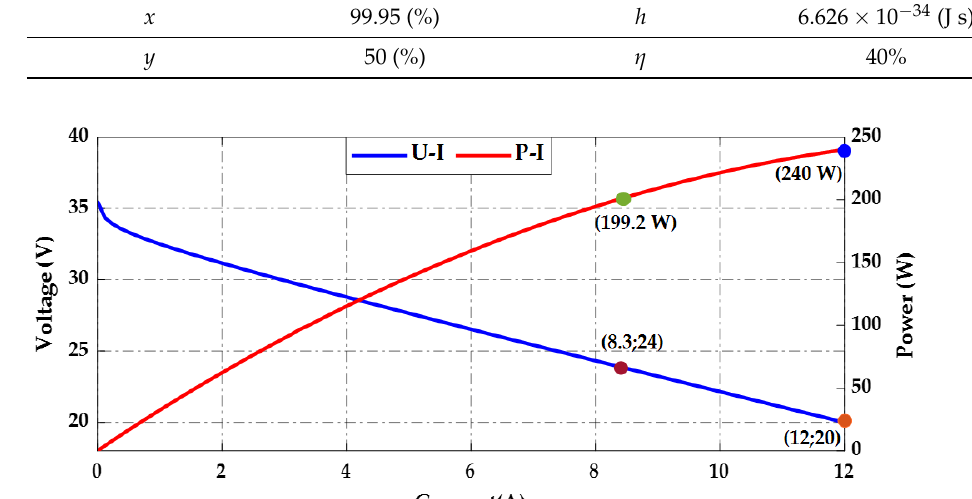
Figure 3. Polarization curves of the PEMFC stack.